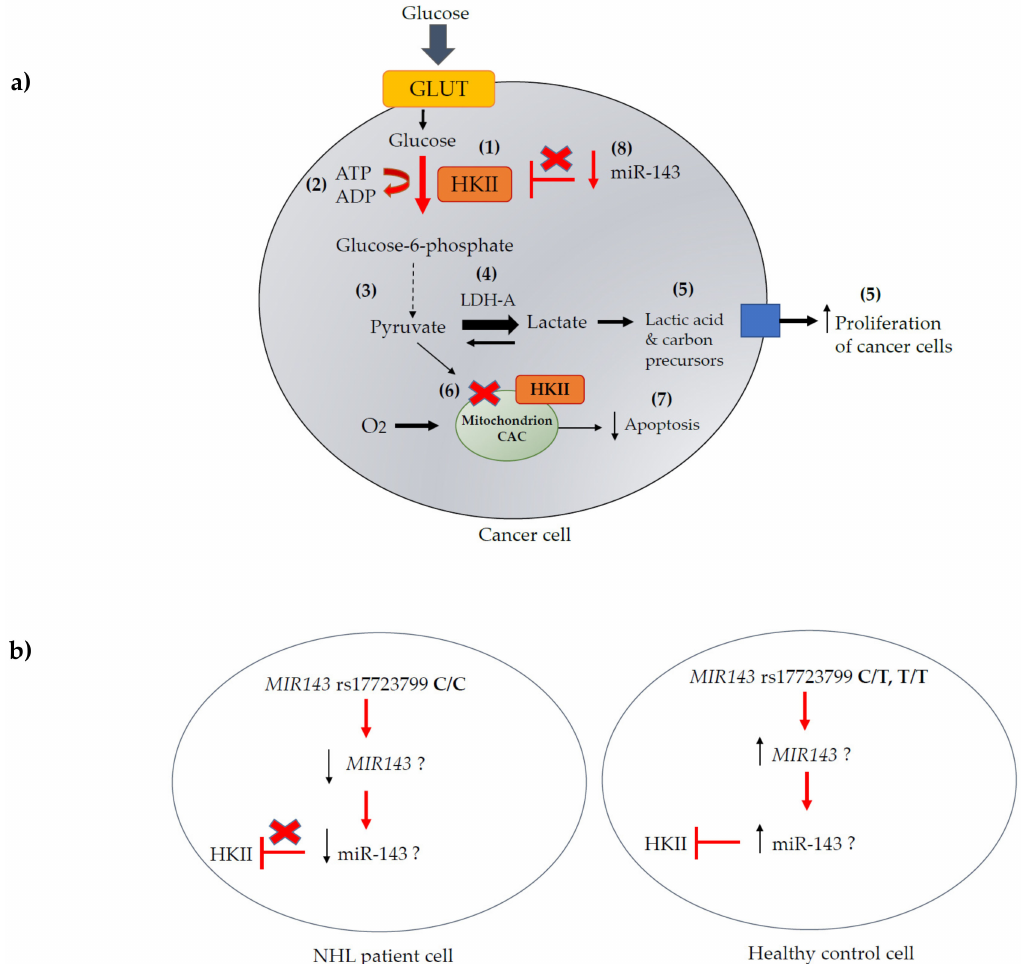
Figure 4. The role of HKII and miR-143 in cancer. ( a ) In a cancer cell, aerobic glycolysis occurs with an increased uptake of glucose and production of lactate even in the presence of oxygen (in normal cells glycolysis is anaerobic) and is known as the “Warburg effect”. Upregulation of Hexokinase 2 ( HKII ) in malignant tumours catalyses the conversion of glucose to glucose-6-phosphate (G-6-P) in the first step of the glycolysis pathway ( 1 ) with high consumption of ATP to ADP ( 2 ) to maintain the high rate of glycolysis required. G-6-P undergoes multiple conversions to pyruvate ( 3 ), which together with high lactate dehydrogenase A (LDH-A) activity in one direction ( 4 ) results in lactic acid production in the cytosol, incorporation of carbon precursors and increased cancer cell proliferation ( 5 ). Oxidation of pyruvate in the mitochondrion is reduced resulting in reduced citrate production for the citric acid cycle (CAC) ( 6 ). HKII bound to the mitochondrial membrane can also enhance cancer by increasing mitochondrial resistance to cell death signals helping to reduce apoptosis ( 7 ). Downregulation of miR-143 has been shown to directly reduce inhibition of HKII ( 8 ) causing increased glycolysis and tumour proliferation. ( b ) In a lymphoid cell, we propose that in the presence of the protective MIR143 SNP rs17723799 genotype CT or TT, there may be increased MIR143 expression and miR-143 transcription with increased targeting of HKII and reduced glycolysis via the Warburg effect causing decreased lymphomagenesis. This hypothesis is speculative, and further functional studies are required. ATP, adenosine triphosphate; ADP, adenosine diphosphate; CAC, citric acid cycle; GLUT, glucose transporter; LDH-A, lactate dehydrogenase A. (Adapted from Wikimedia [52] and Akins et al. (2018) [23])